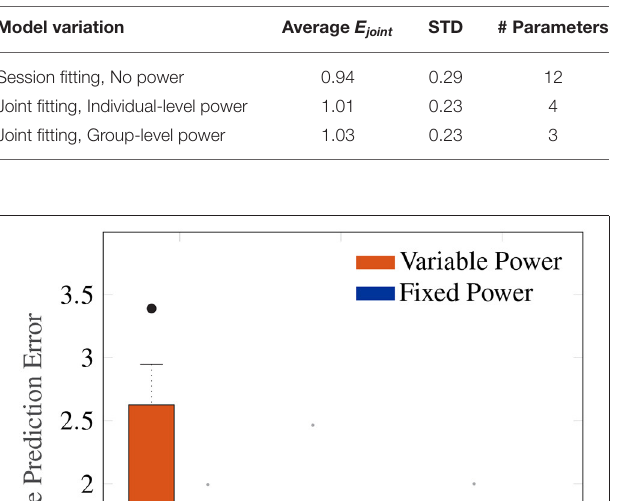
TABLE 1 | Summary of fitting results, with the error averaged over participants E joint , the standard deviation over participants in the MAE, and the number of parameters for each model variation.